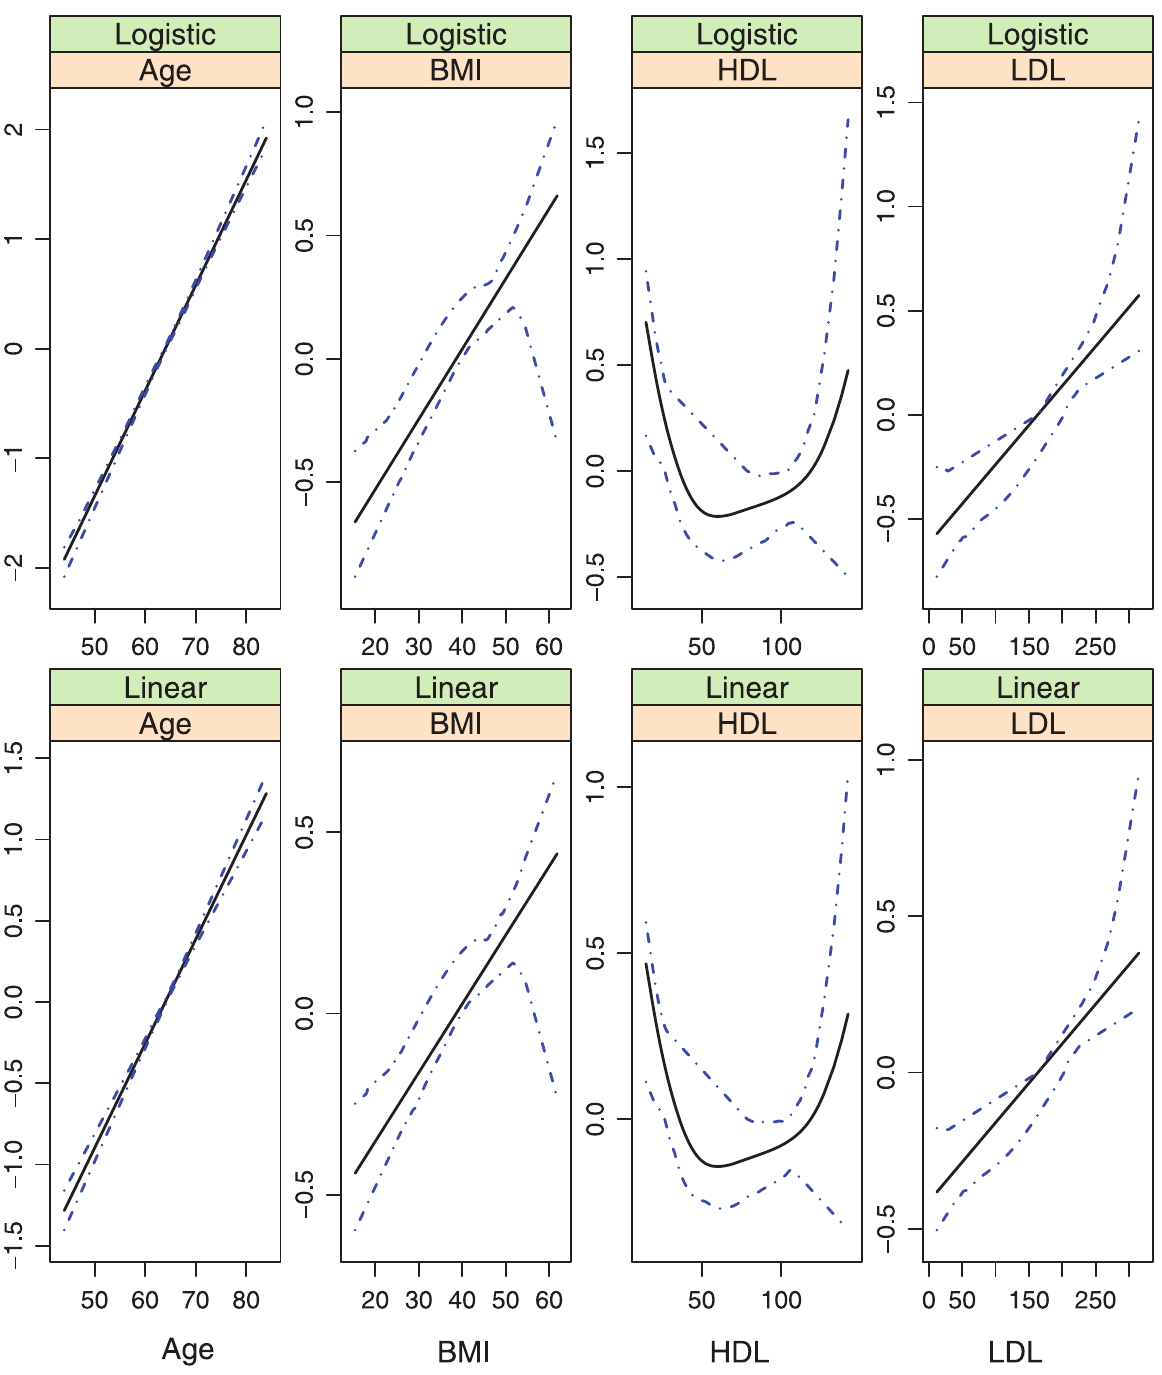
Figure 6. Model (iii): estimated covariate effects for age, BMI, HDL, and LDL. The solid line is the estimate. The dash-dotted lines are the point-wise 95% confidence intervals. The y-axis is the value of the function.